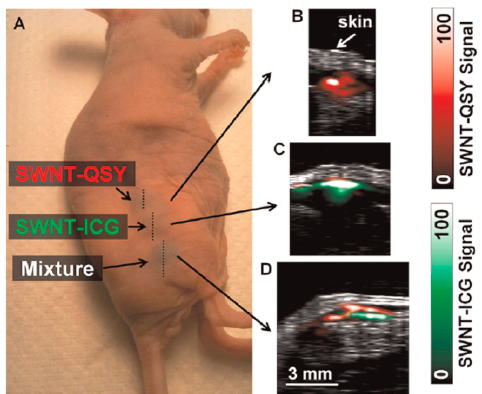
Figure 15. Animal testing of QSY 21 and ICG labeled SWNTs. Three separate subcutaneous injections were performed on a single mouse as shown in ( A ). The first contained QSY labeled SWNTs, the second contained ICG labeled SWNTS, and the third contained a mixture. These are shown respectively in inset images ( B – D ). Figure from [101] reproduced with permission from the publisher.